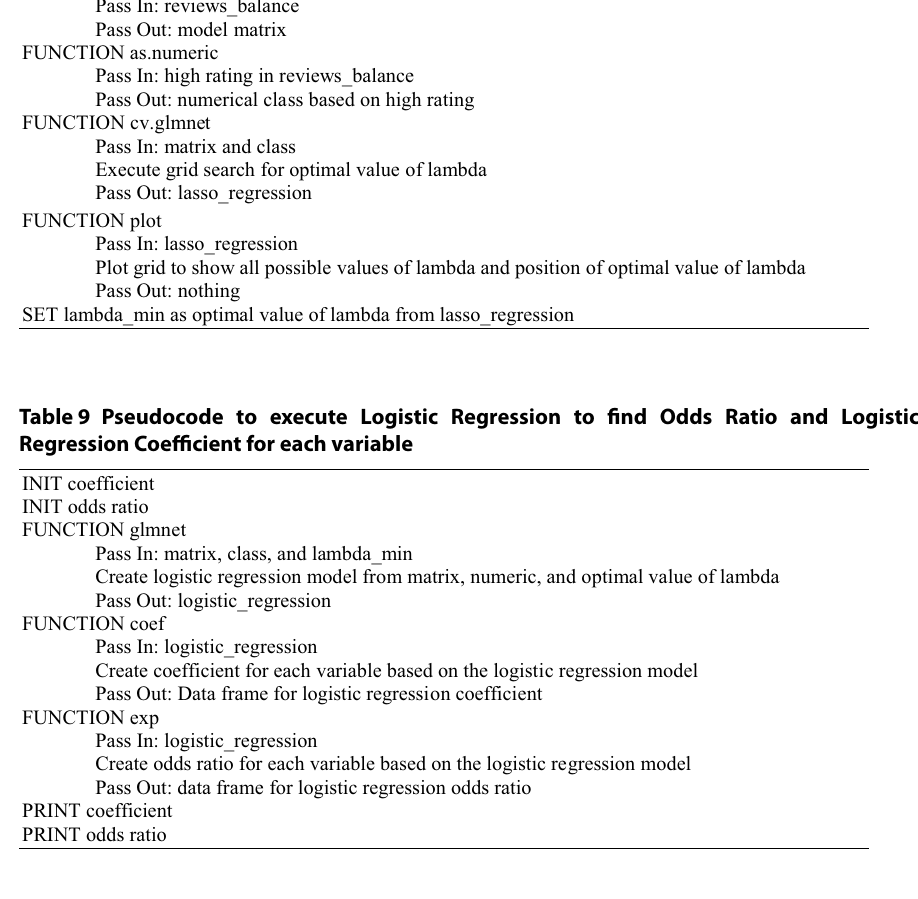
Table 8 Pseudocode to execute LASSO Regression to find Minimum Lambda to be used in Logistic Regression INIT glmnet package INIT matrix to store converted training data as matrix format INIT class to store converted classification as numerical variable INIT lasso_regression to store results from grid search to find optimal value of lambda FUNCTION model.matrix Pass In: reviews_balance